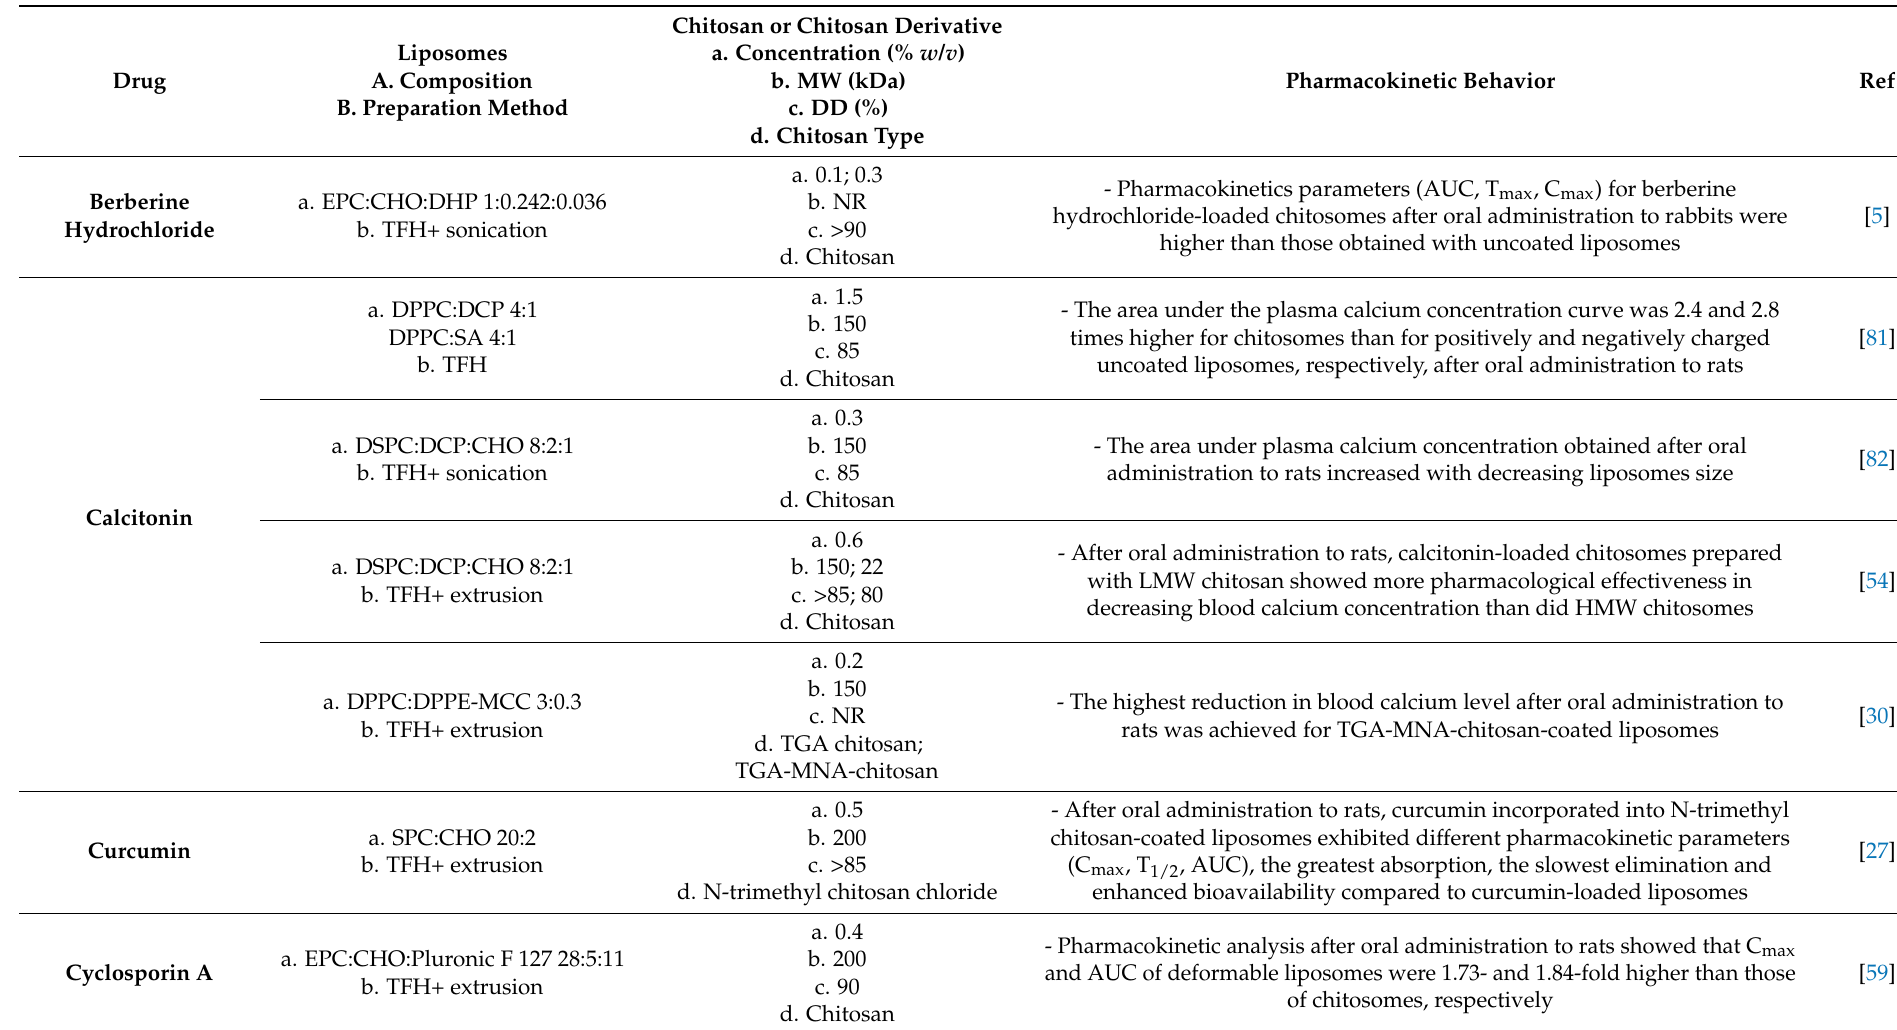
Table 7. Drug pharmacokinetic behavior: conventional liposomes and chitosomes. The liposomal composition is indicated in the table in molar ratio except when * exists, indicating a weight ratio ( w/w